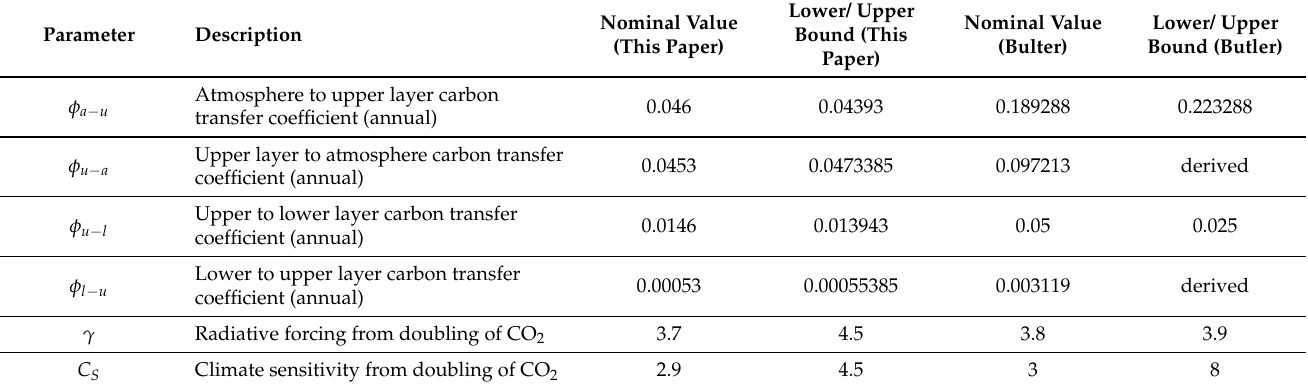
Table A1. Nominal values for climate parameters and comparison with